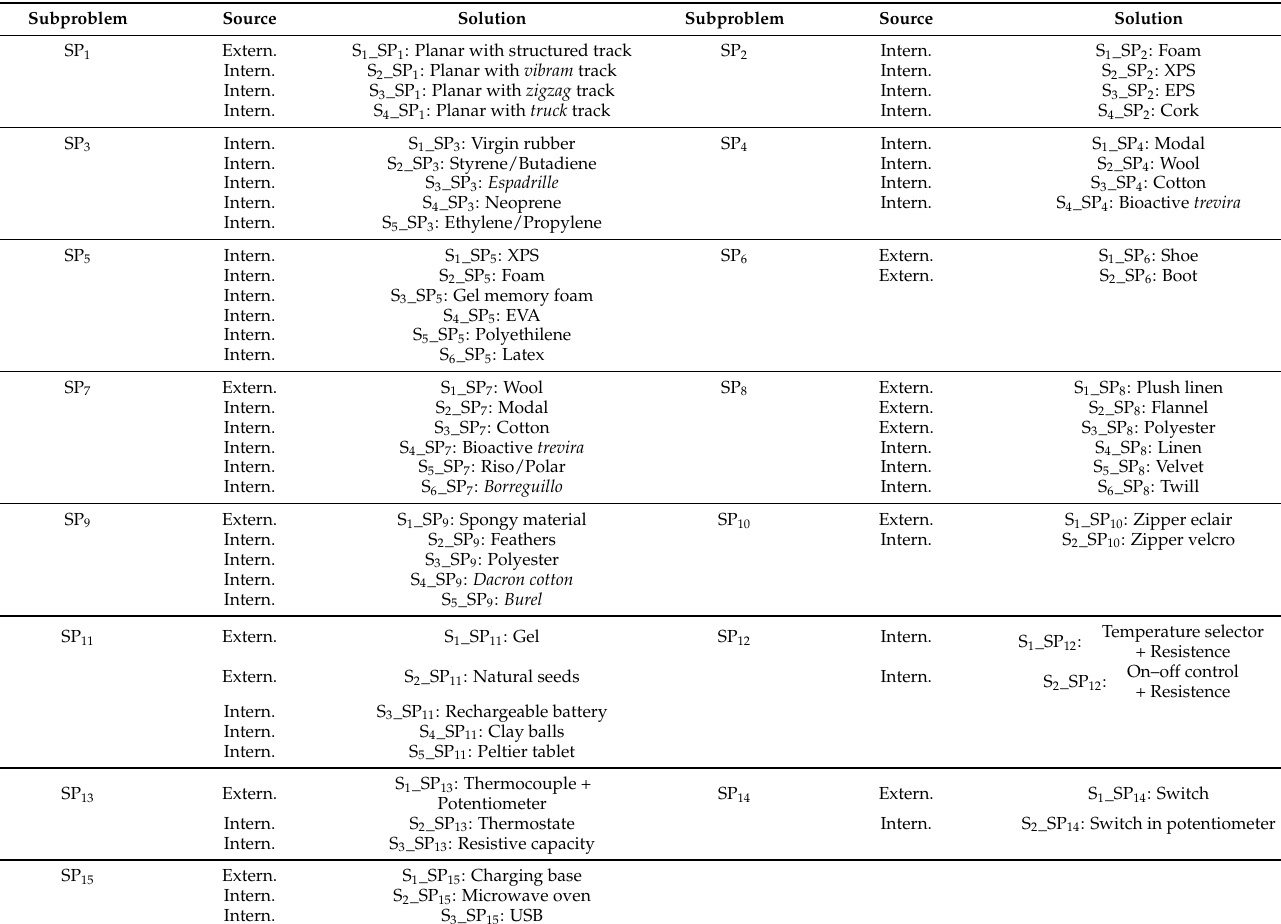
Table 11. Solutions prescribed for subproblems in Table